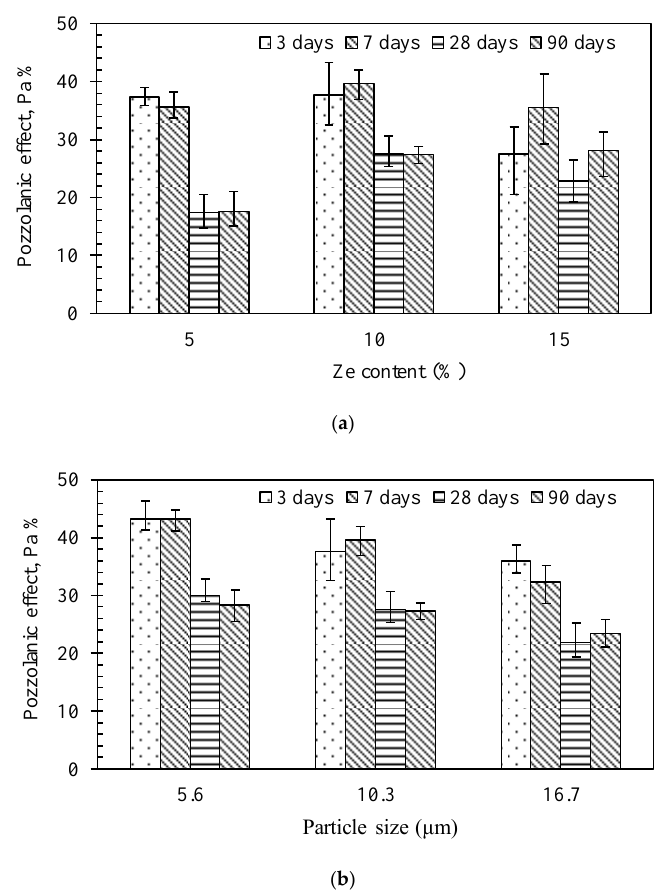
Figure 9. Effect of the zeolite content ( a ) and the particle size of zeolite ( b ) on the pozzolanic effect of zeolite in the HPC system.